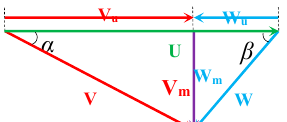
Figure 2. The breakdown drawing of the velocity triangle.